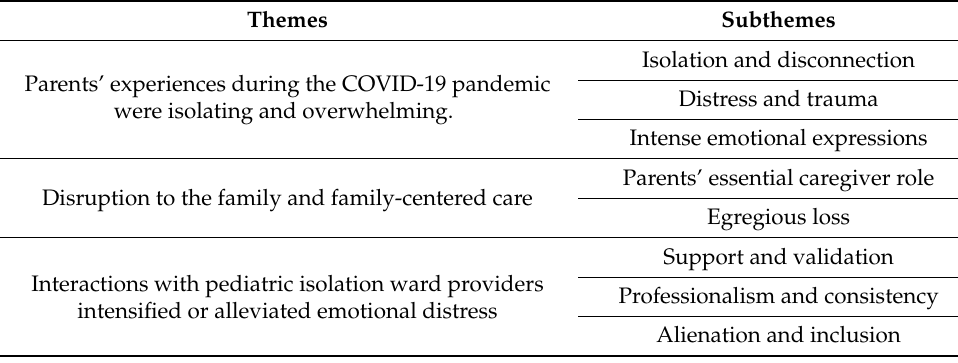
Table 3. Themes and